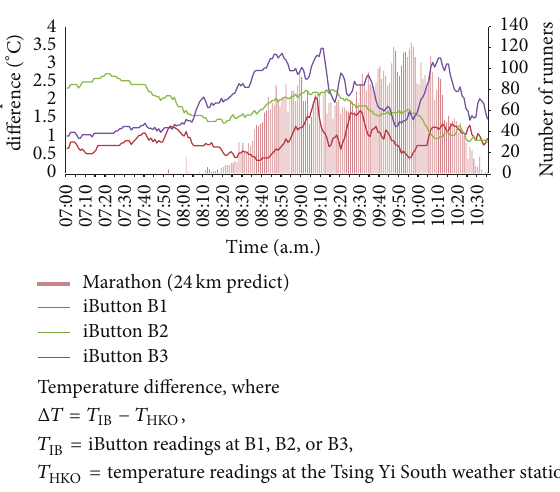
Figure 5: Minute-by-minute vapour pressure difference and runner counts at the Stonecutters Bridge (Site A: open space).